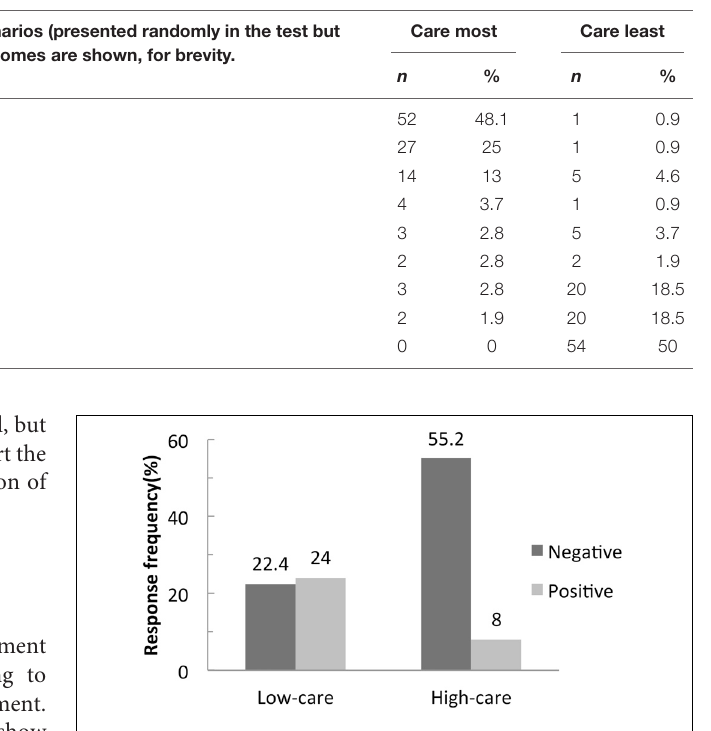
FIGURE 1 | Proportions of intention ascription for negative and positive side effects, for scenarios that elicited highest or lowest